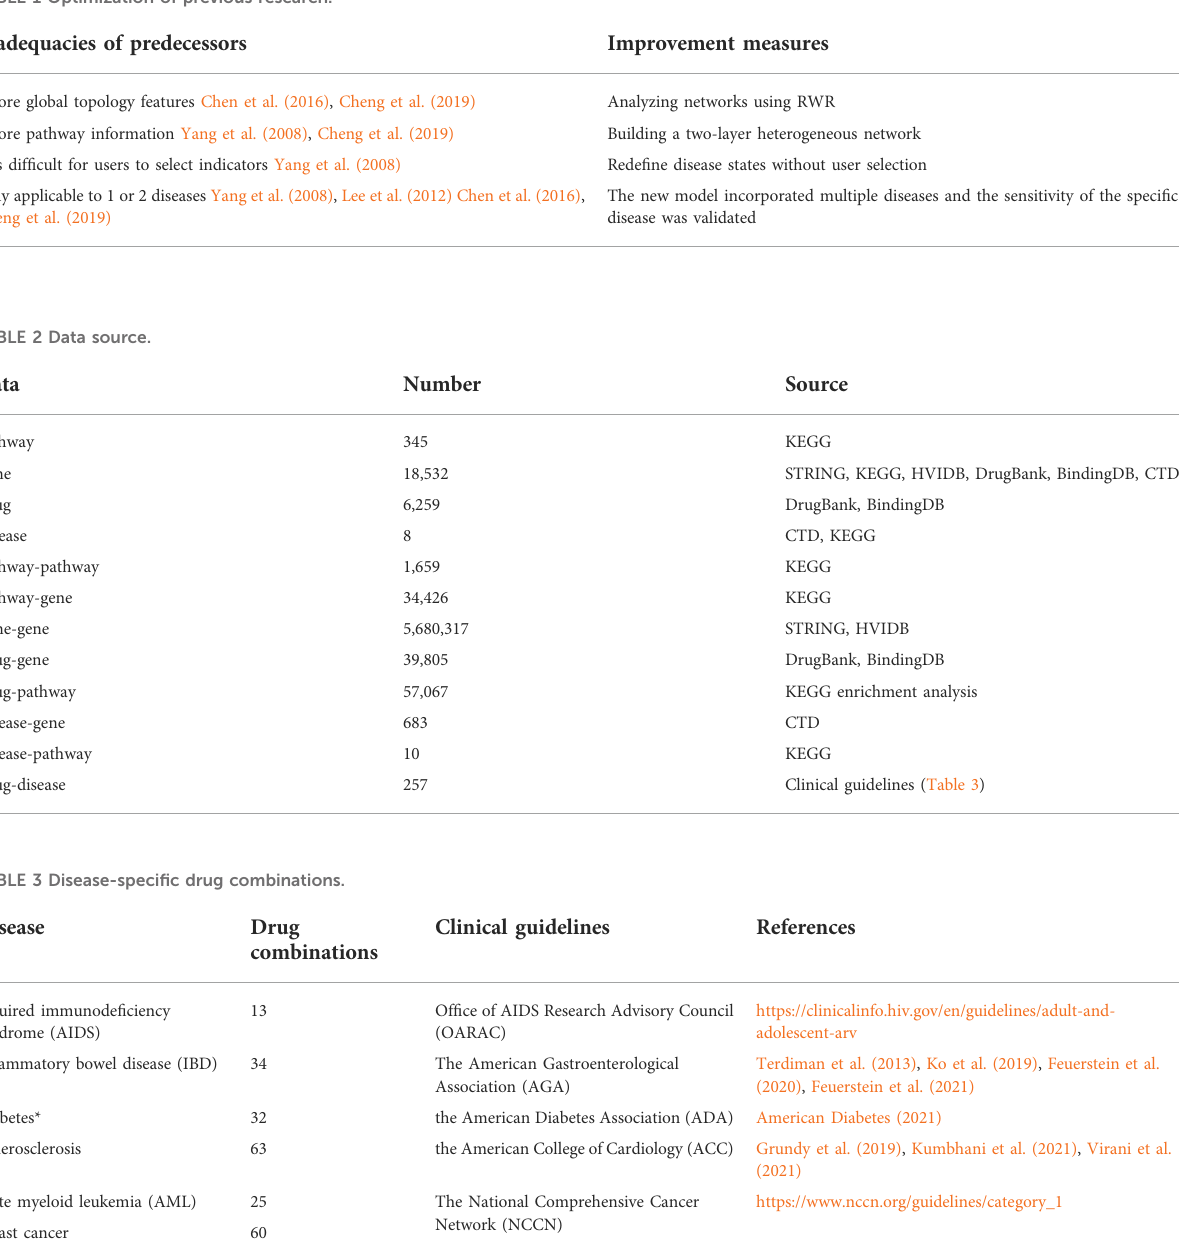
TABLE 1 Optimization of previous research.